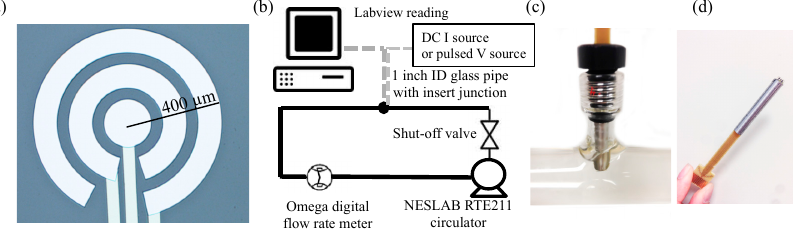
Figure 1. ( a ) Sensor geometry; ( b ) System schematic; ( c ) The sensor inserted into a 1-inch diameter pipe; and ( d ) The assembled sensor probes.